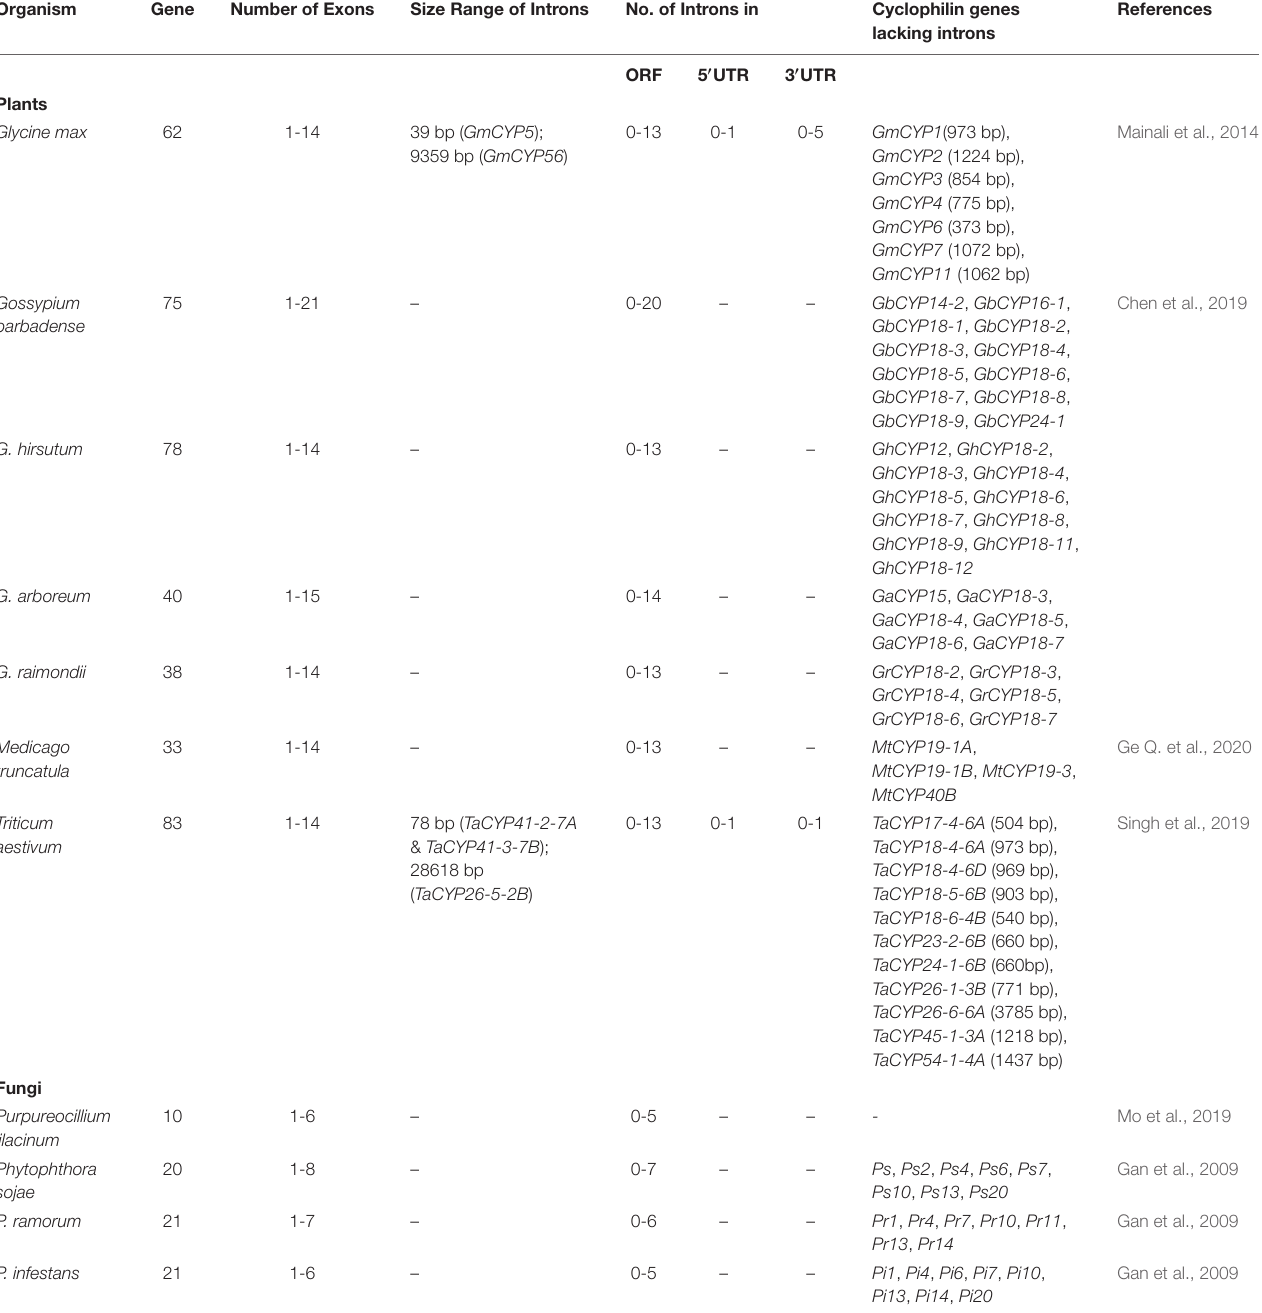
TABLE 4 | Variability in architecture of cyclophilin